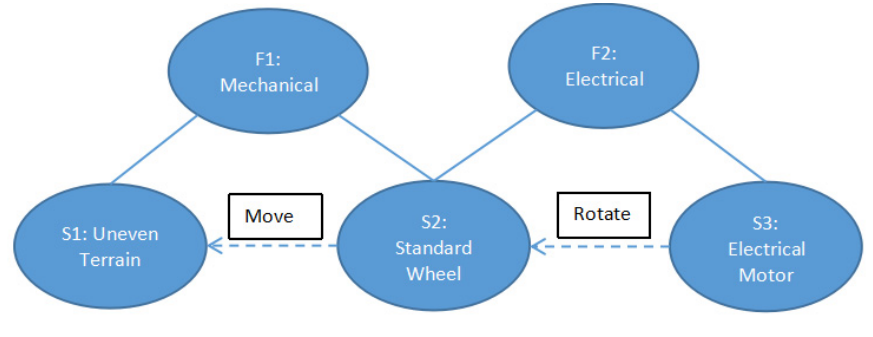
Figure 3. Su-field model for constraint 1.